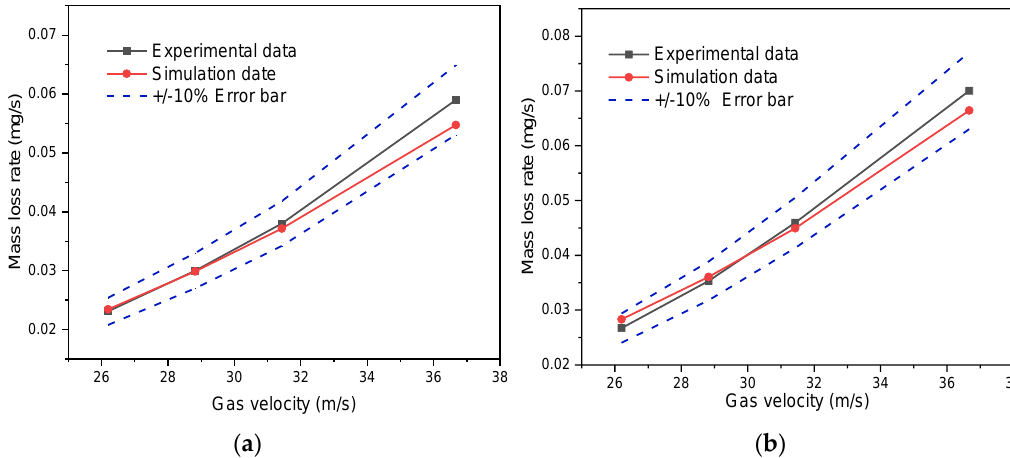
Figure 4. The relationship between erosion rate and gas velocity. ( a ) Particle mass flow rate 10 g/s; ( b ) Particle mass flow rate 12 g/s.